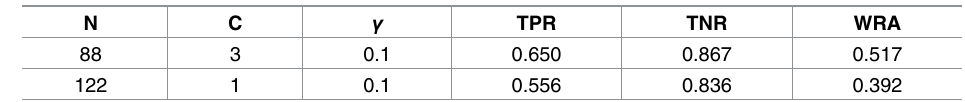
Table 4. Peformance of SVMs.